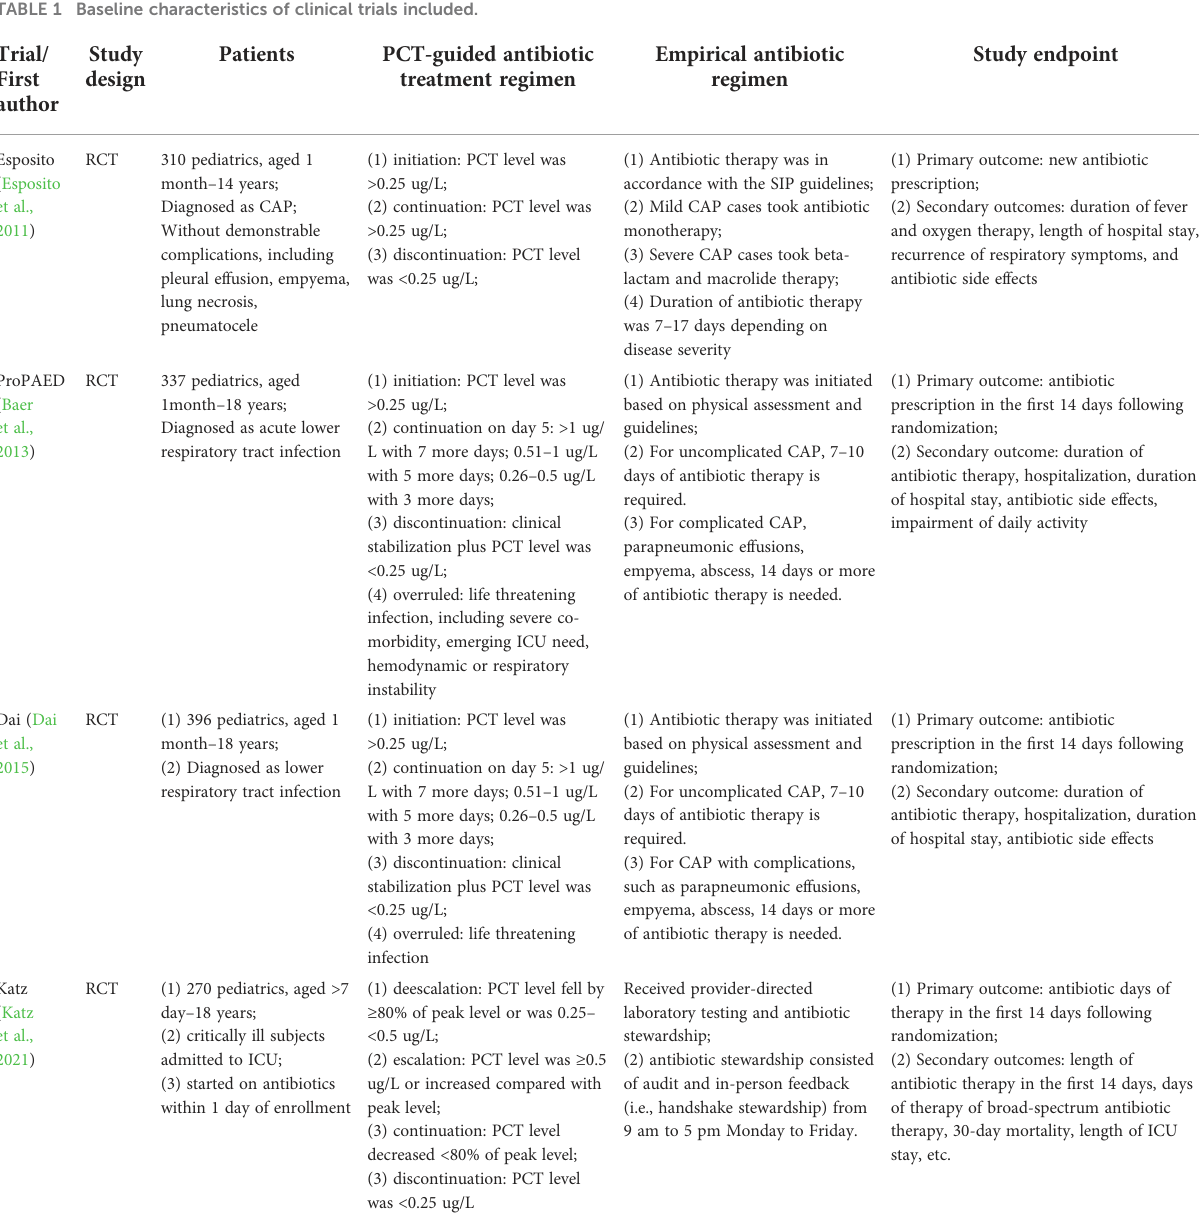
TABLE 1 Baseline characteristics of clinical trials